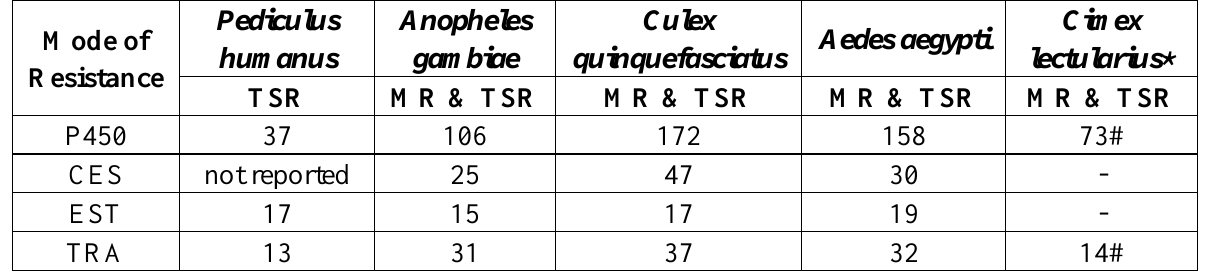
Table 1. Mode of resistance and number of cytochrome P450s, carboxylesterases, esterases, and transferases among the genomes of blood-feeding insects 19,66-69